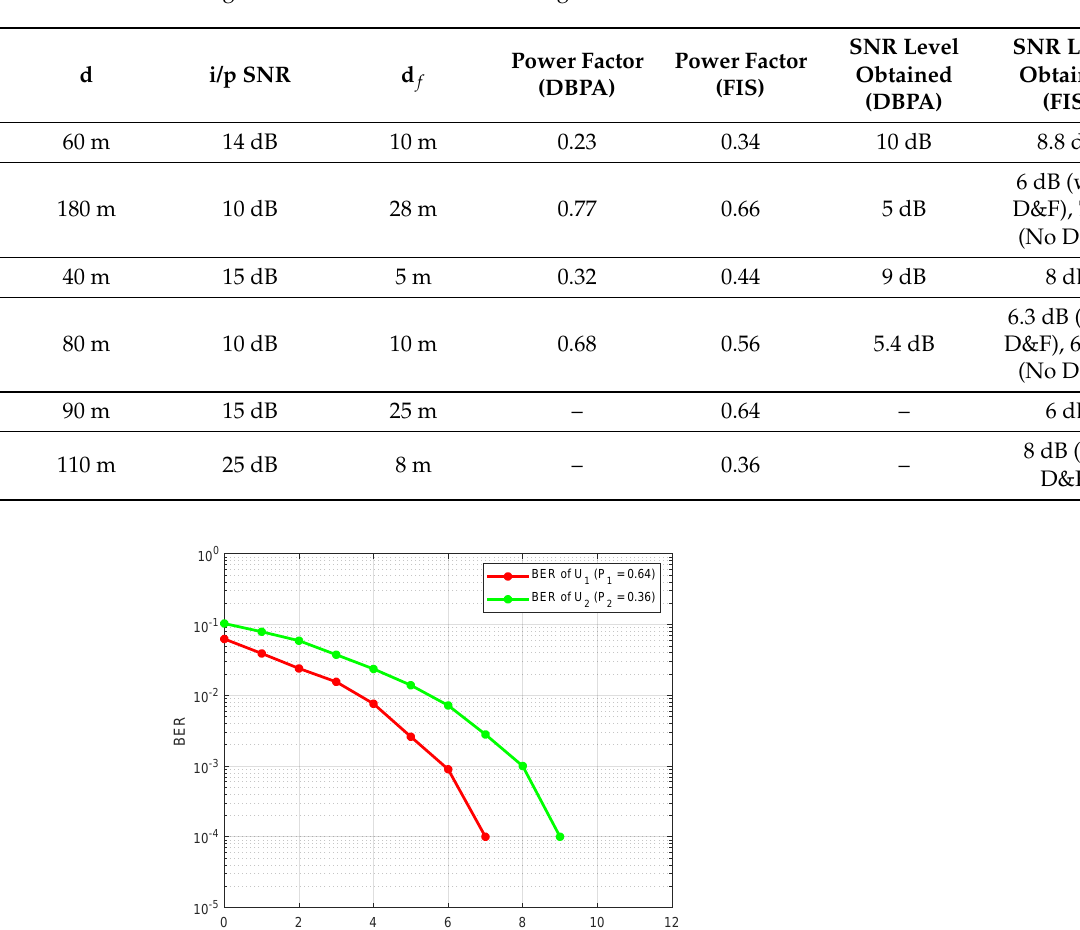
Table 3. Performance analysis of two users in PD-NOMA and Cooperative PD-NOMA with PA through DBPA and the FIS-based strategies.